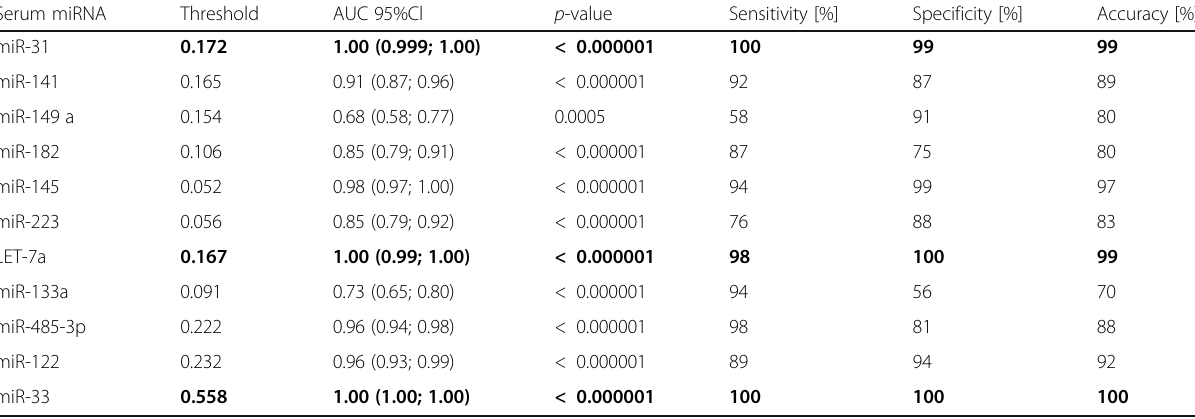
Table 3 The Receiver Operator Characteristic curve values for the expression of the eleven serum miRNAs and the corresponding calculated AUC Serum